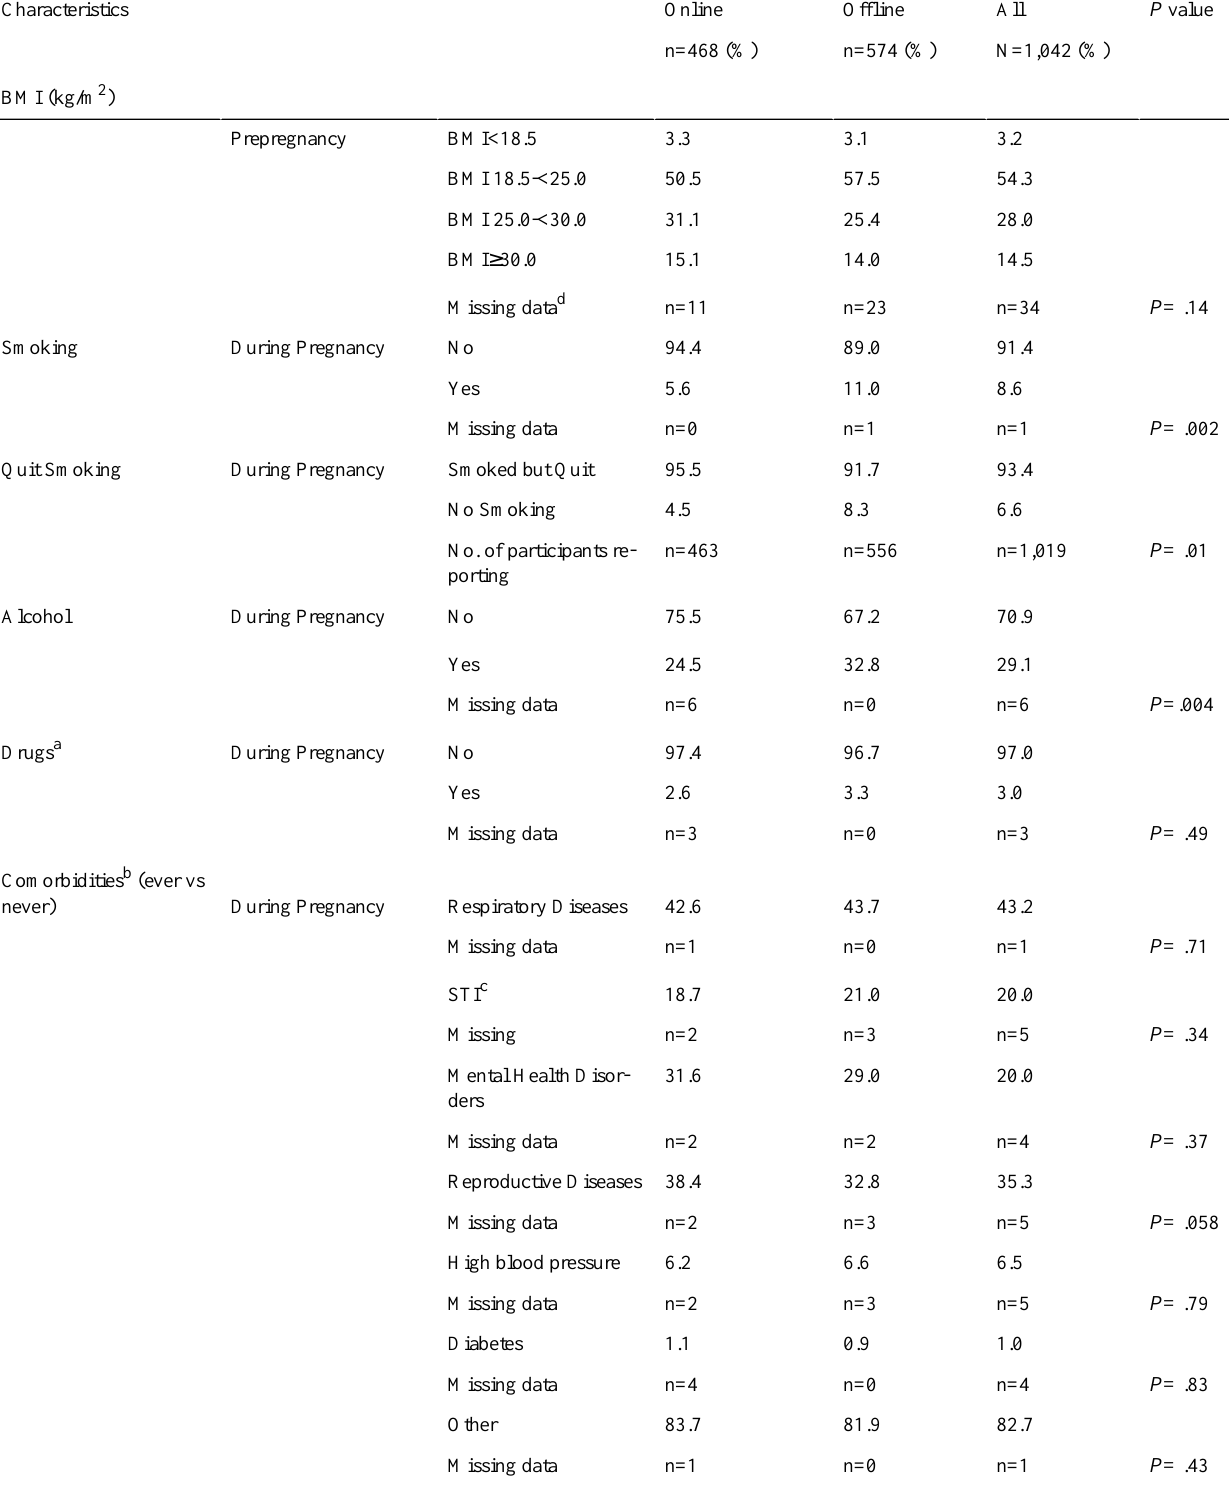
Table 4. Selected key exposures of online versus offline participants of the ELF cohort.